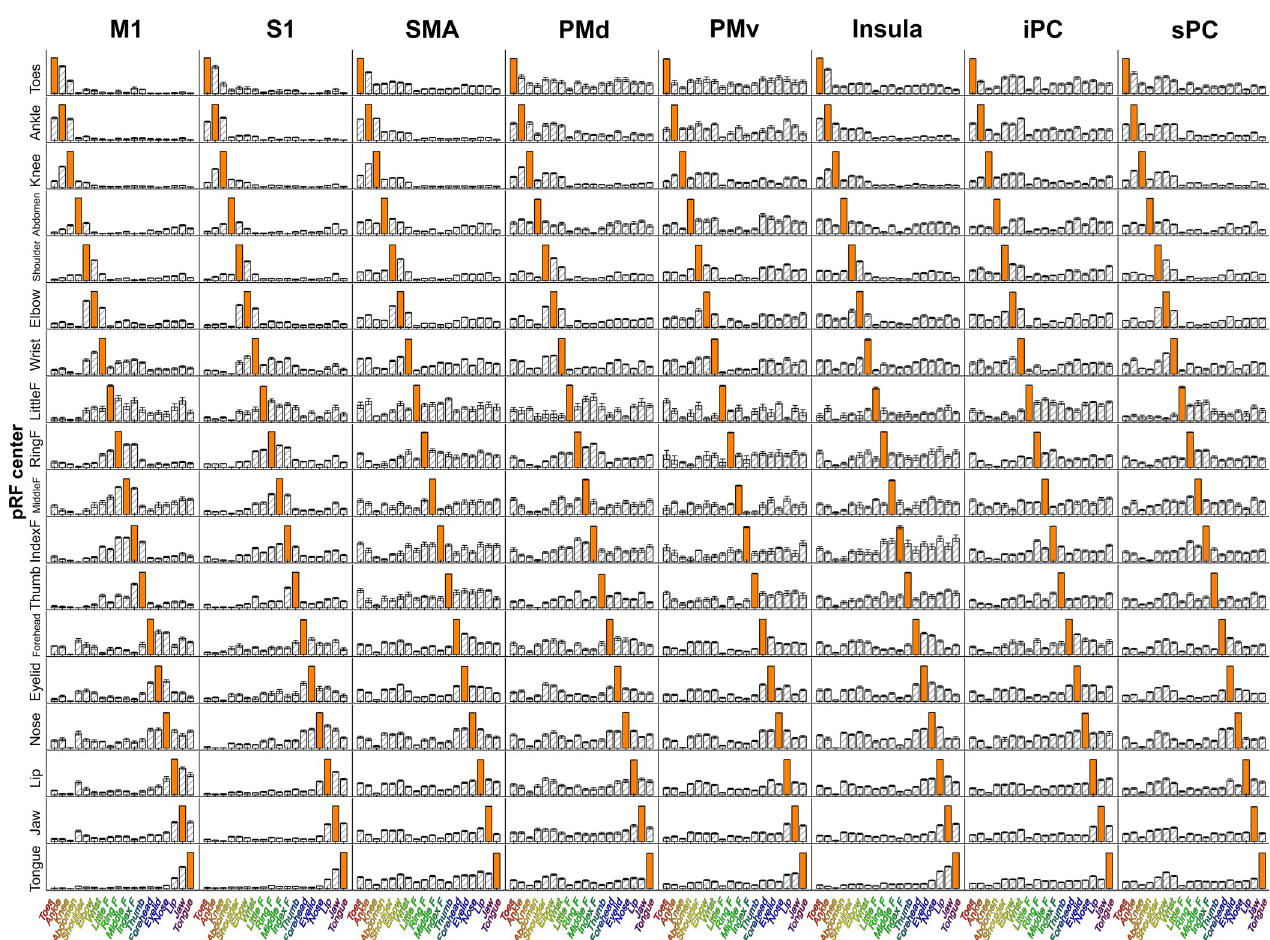
Fig 6. Mean body part pRF. For each ROI (columns), the complete response field was normalized and averaged over all vertices sharing the same pRF centers (rows), creating the mean body part pRF (i.e. 18 body part positions per pRF center and ROI). The bars denote the proximity of body parts to the center of the response field. The higher the bar, the closer the corresponding body part is to the response field’s center. For each mean body part pRF, the body part equal to the pRF center is depicted by the orange bar, and is by definition closest to the response field center. The Error bars denote the S.E.M. across subjects.